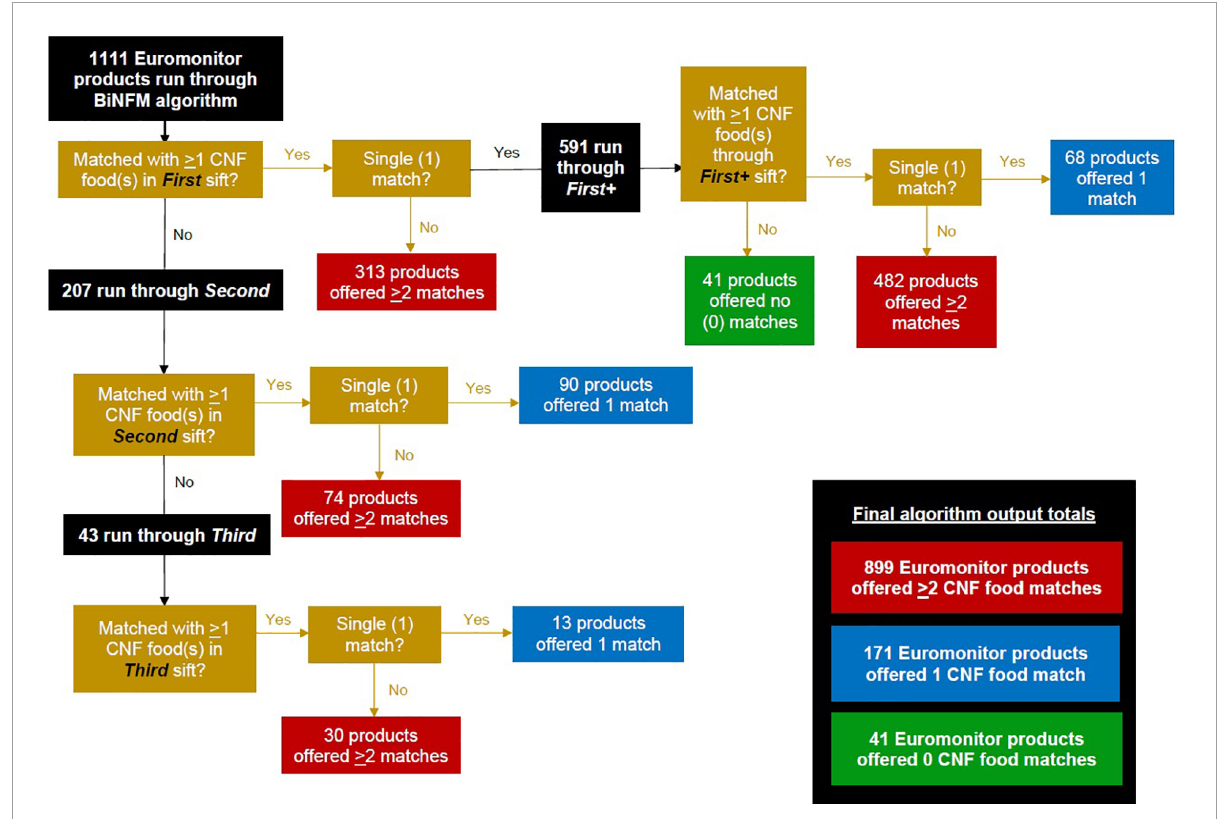
FIGURE6 Overview of Euromonitor products’ coursing through the algorithm’s four sifts (by level of match output: 0, 1, or ≥ 2 matches).